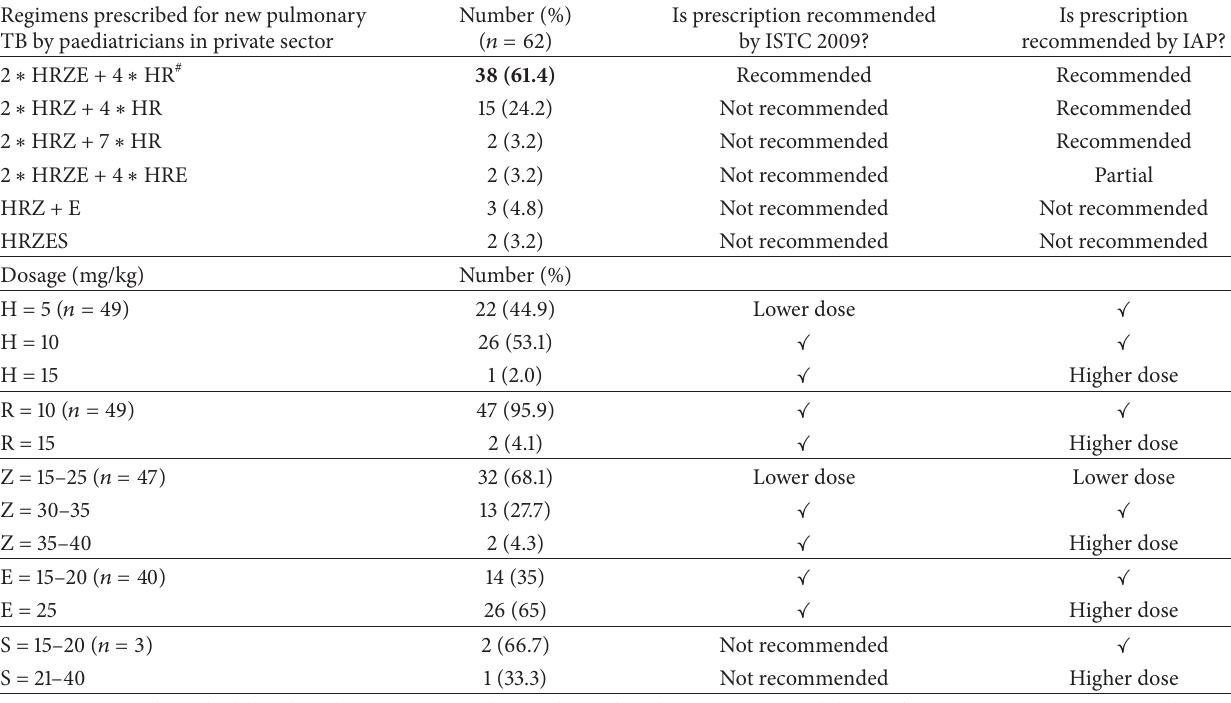
Table 4: Comparison of anti-tubercular regimens prescribed for new patients by paediatricians in private sector with standard guidelines. Regimens prescribed for new